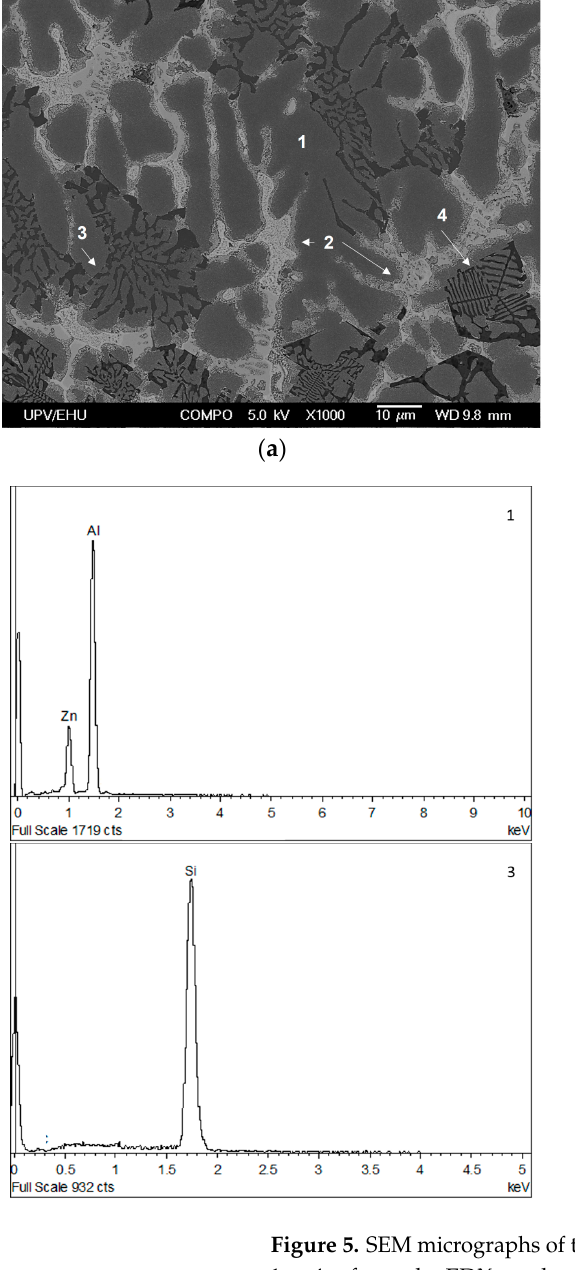
( b ) Figure 6. SEM micrographs of the Al–Zn matrix. ( a ) As-cast. ( b ) Q380. The identification of the phases present in each initial thermal condition was performed by room temperature X-ray diffraction (before the heating cycle). As is shown in Figure 7, in addition to the Al phase (PDF: 00-004-0787) and the Pt phase from the sample holder (PDF: 04-013-4766), which are not indicated for clarity, the phases detected were Zn (PDF: 01-078-9363), Si (PDF: 00-027-1402), MgZn 2 (PDF: 04-003-2083), Mg 2 Zn 11 (PDF: 04-007-1412), and Mg 2 Si (PDF: 01-083-5235).